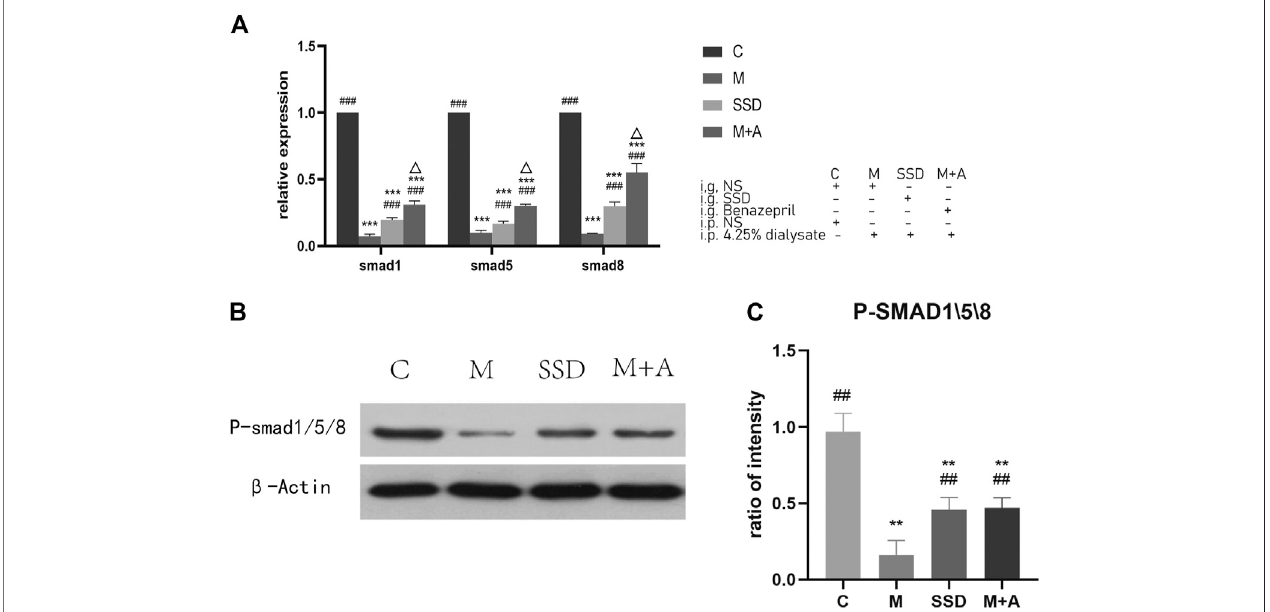
FIGURE 5 | (A) Expression of Smad1/5/8 of peritoneal tissue by PCR. (B) WB of P-smad1/5/8. (C) Quanti fi cation of protein levels of Smad1/5/8. Data are presented as mean ± SD ( n (cid:2) 3). For comparison with the group M ## indicates p < 0.01; for comparison with the C group, ** indicates p < 0.01 and *** indicates p < 0.001; for comparison with the group M, ## indicates p < 0.01 and ### indicates p < 0.001; for comparison with the SSD group, △ indicates p < 0.01.